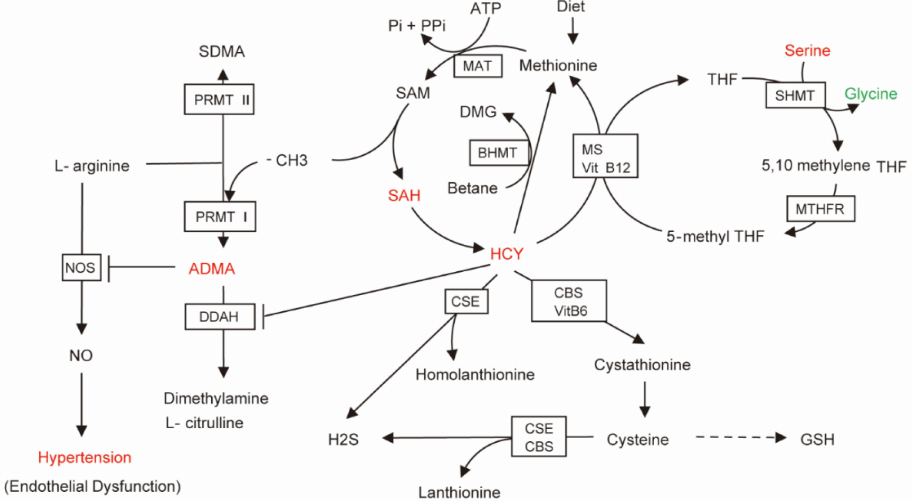
Figure 7. Brief diagram of HCY metabolic pathways related to hypertension. The arrow direction is the direction of metabolite generation. The red metabolites represent up-regulated metabolites satisfying FC > 1, p < 0.05, green metabolite represents down-regulated metabolite satisfying FC < 1, p < 0.05. Enzymes acting on the pathway are shown in the